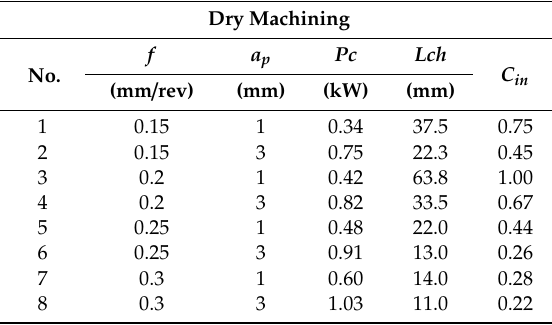
Table 8. Average power consumption ( Pc ), chip length ( Lch ) and chip breaking index ( C in ) values for dry machining.